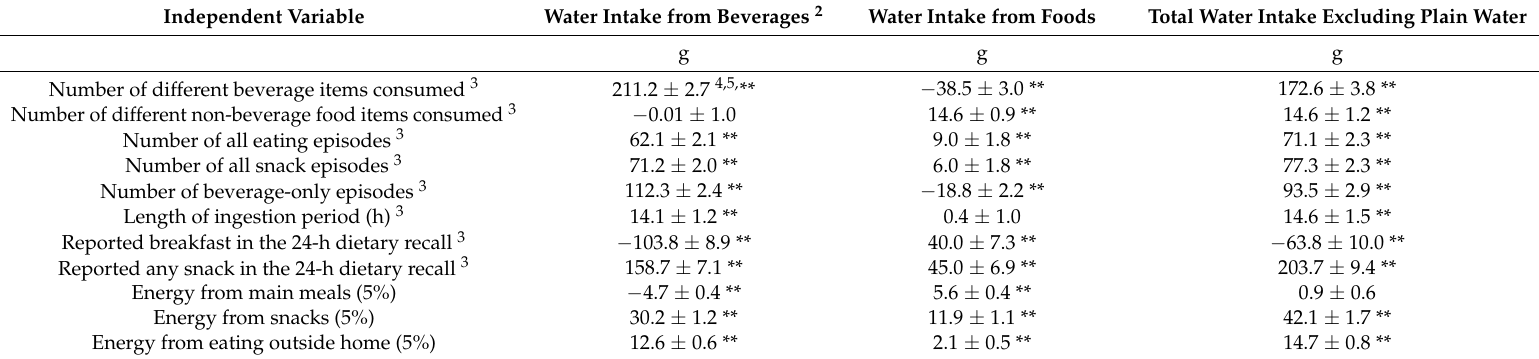
Table 4. Water intakes from beverages and foods associated with eating behaviors in Korean adults, KNHANES 2008–2012 1